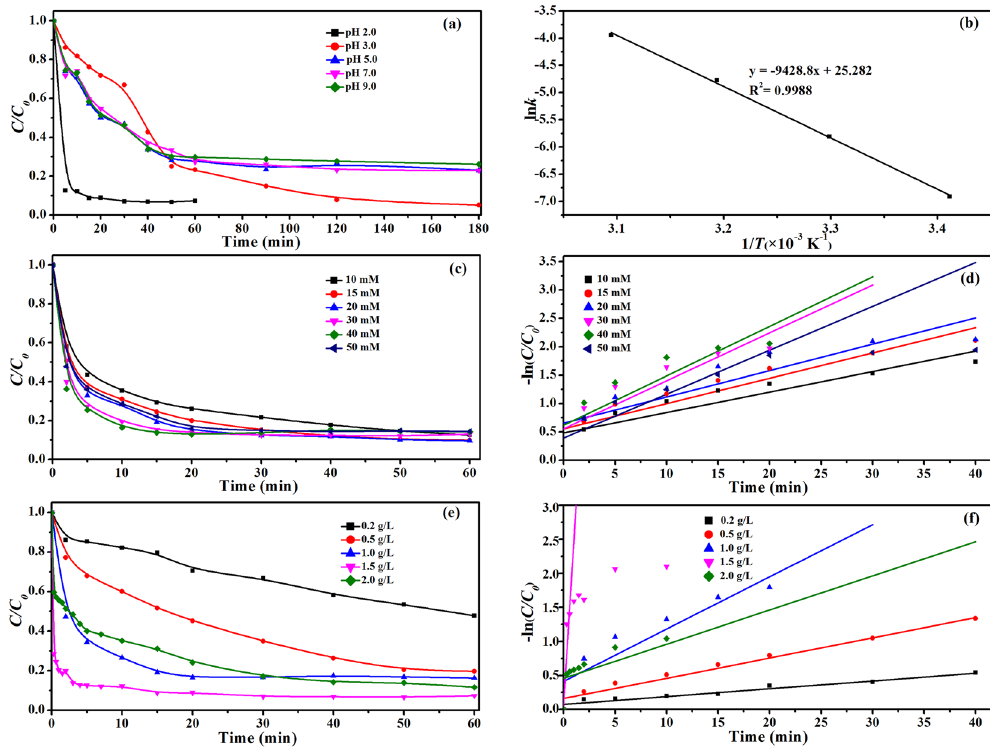
Figure 5. Factorial effects of heterogeneous Fenton reaction on EtBr (80 mg/L) degradation by A-ATP@ Fe 3 O 4 : ( a ) initial pH value, and ( b ) Arrhenius plot based on the effect of temperature. ( c ) H 2 O 2 dosage, ( e ) A-ATP@Fe 3 O 4 composite addition, ( d ) and ( f ) Pseudo-first-order kinetics corresponding to ( c ) and ( e ) (where the slope of the plot of − ln( C/C 0 ) versus reaction time is the apparent degradation rate constant k ). Except for the investigated parameter, other parameters were fixed: catalysts load 1.5 g/L, initial H 2 O 2 concentration 30 mmol/L and the temperature of the system 323 K of ( a ), catalysts load 1 g/L, pH 2.0, initial H 2 O 2 concentration 15 mmol/L of ( b ). And catalysts load 1 g/L, pH 2.0, the temperature of the system 323 K of ( c ) and ( e ), pH 2.0, initial